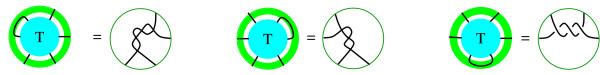
Tangle equations (crossings are either all right-handed or all left-handed). This system of tangle equations is equivalent to the system of tangle equation in Fig. 6 in that both systems have the same solution set.